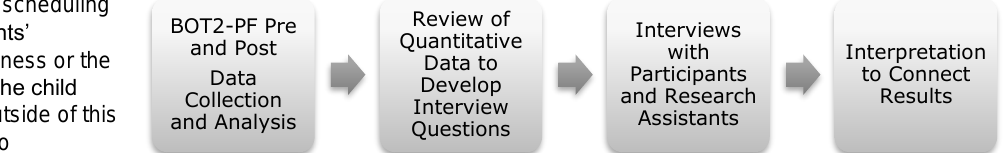
Figure 3. Use of sequential explanatory design for the current project.